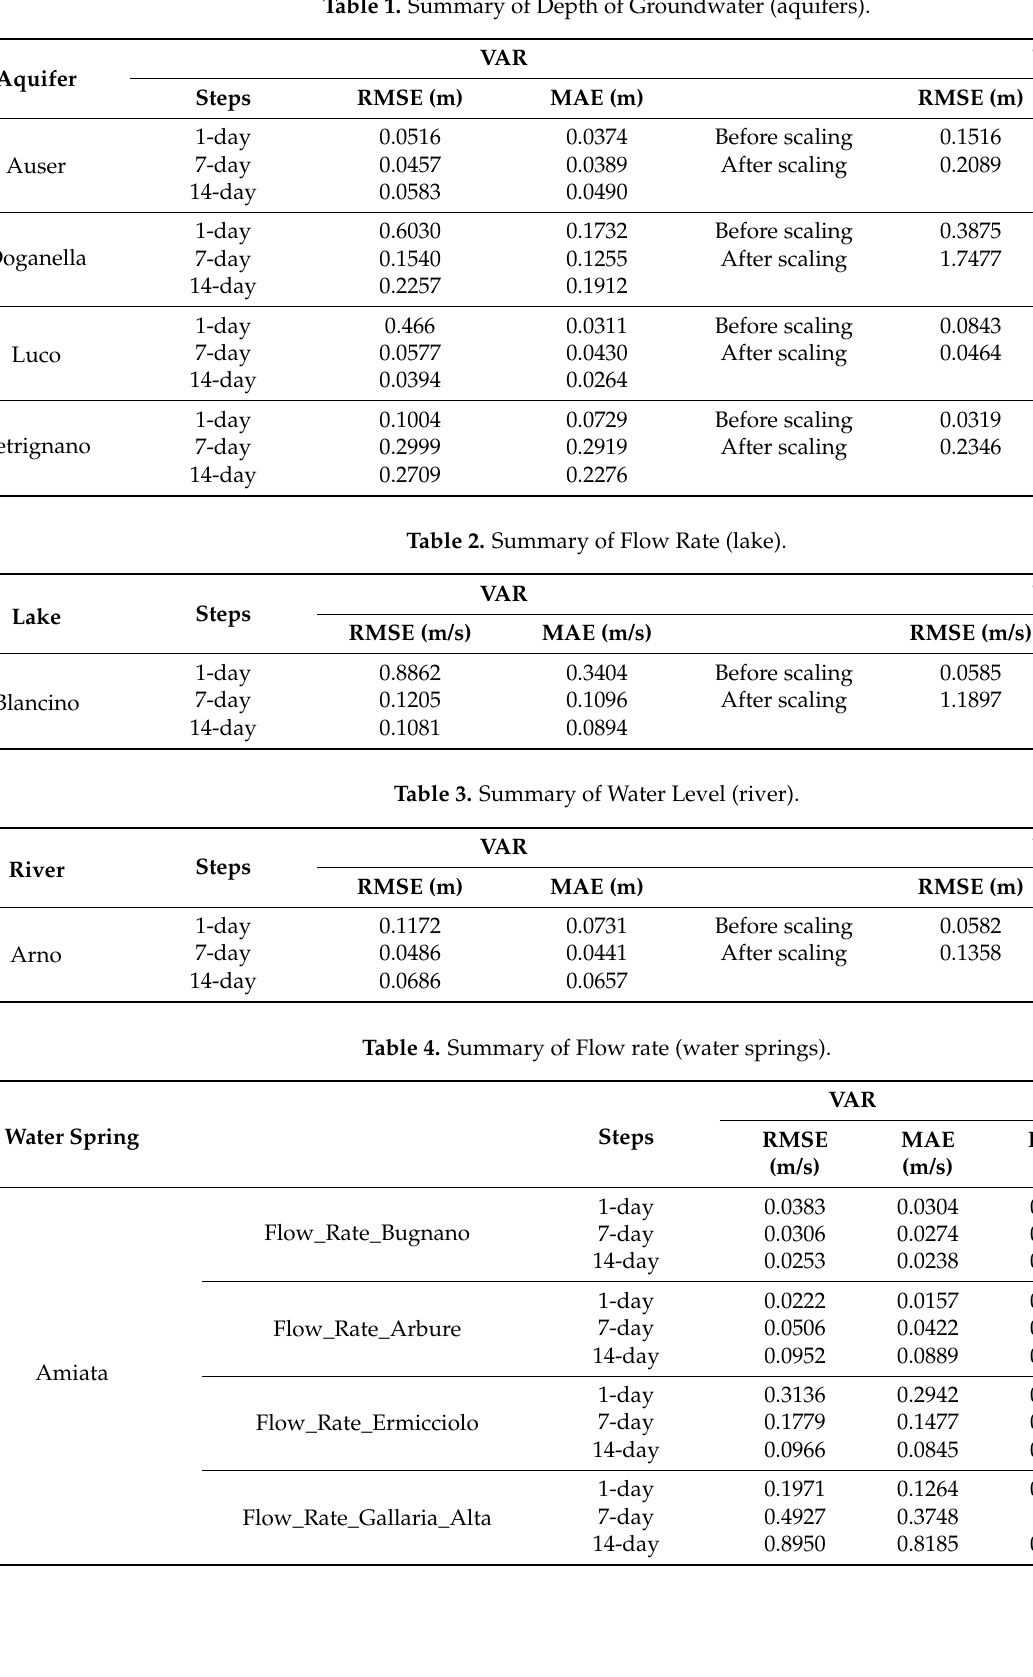
Table 1. Summary of Depth of Groundwater (aquifers).